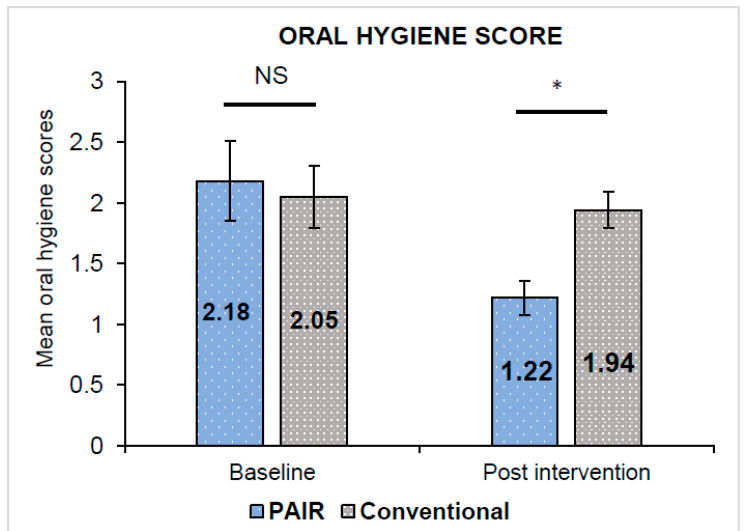
Figure 4. Comparison of mean oral hygiene score in PAIR technique group and conventional tech- nique group. All values are expressed as mean ± standard deviation. The statistical test used: Un- paired t -test; * Statistically significant, p ≤ 0.05; NS: not significant.